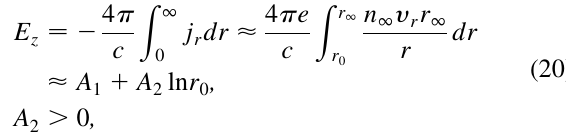
(cid:14) (cid:3) r , the logarithmic increase of j E 0 0